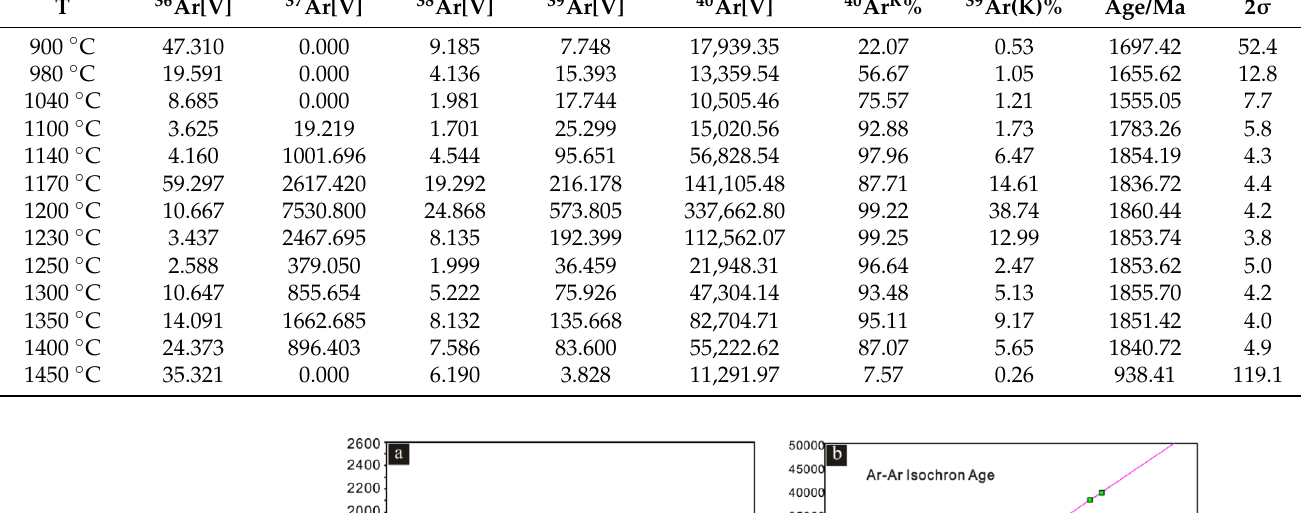
Table 1. 40 Ar- 39 Ar data of tremolite from the Lijiapuzi gold deposit.